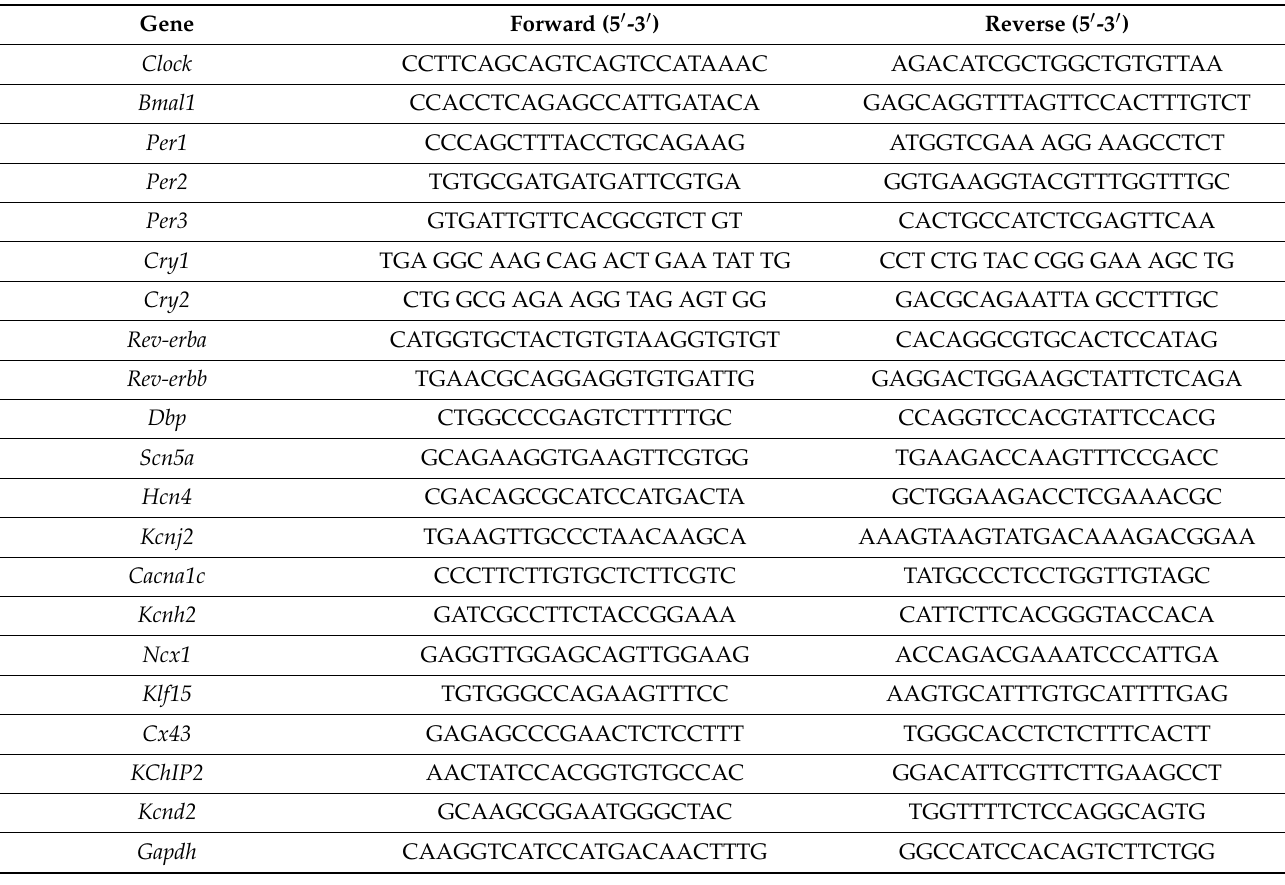
Table 1. qPCR primer